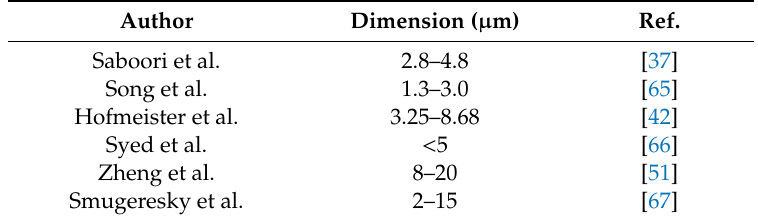
Table 2. A summary of PCAS reported for AISI 316L alloy processed by DED.